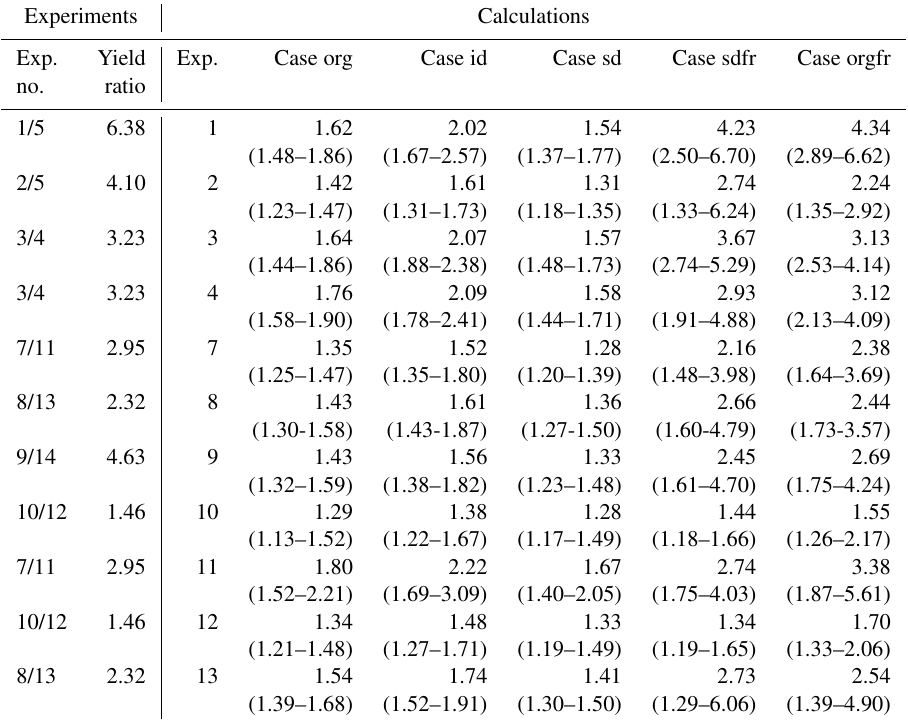
Table 2. Increase in organic yield from low to high RH for the different experiments as org yield (high RH)/org yield (low RH). The second column lists the ratio of measured organic yield enhancements with RH. In the five last columns the ratios of organic yields calculated at high and low RH for the different experiments are given (average value of the 10 volatility distributions with lowest and highest values in brackets in the second